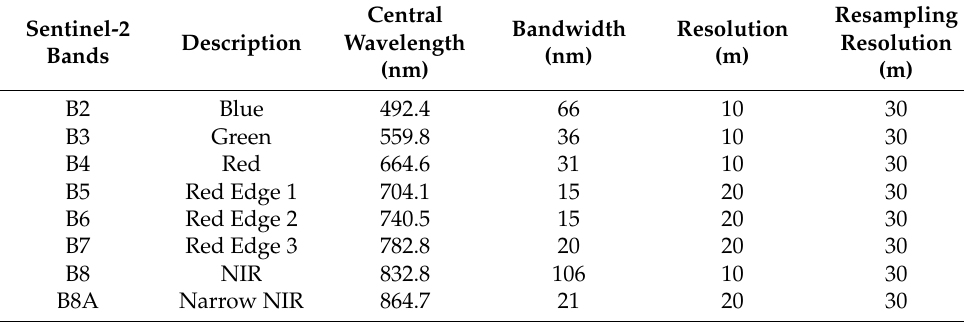
Table 2. Selected band information of